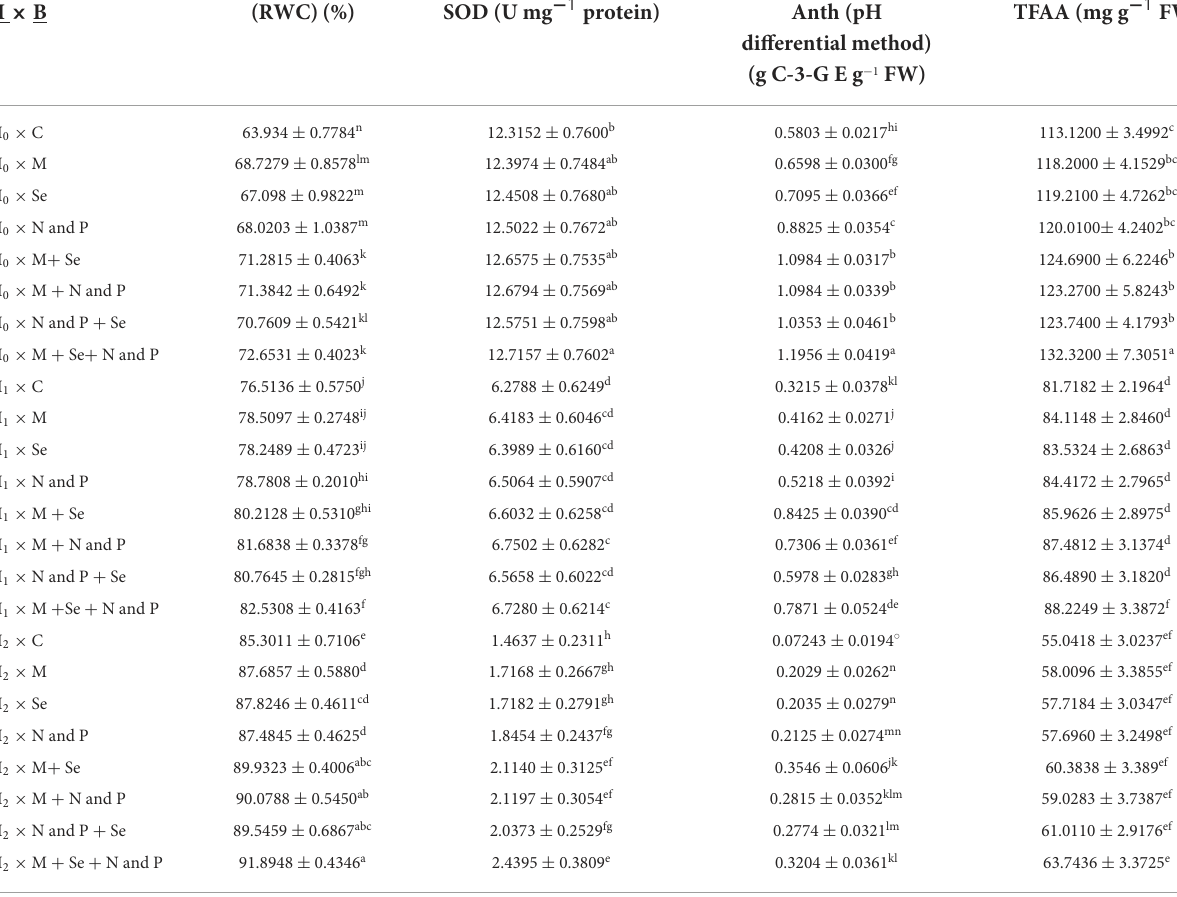
TABLE 3 Mean comparisons of the dual interactions of irrigation levels and bio fertilizers on RWC, SOD, Anth, and TFAA traits in 2017–2018. I × B